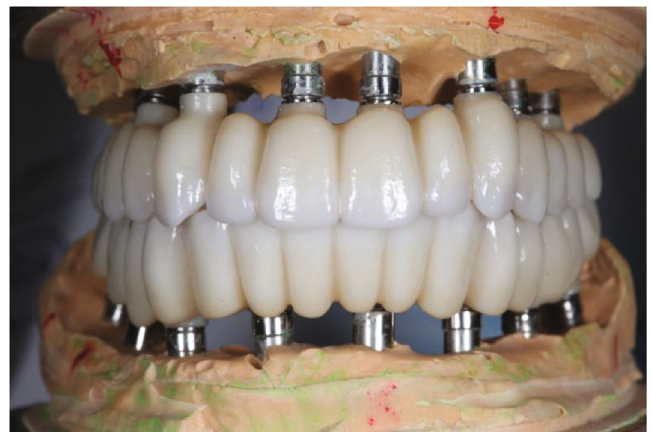
Figure 8: Final look of the zirconia full-arch prostheses. Afterwards, the titanium bases were inserted.